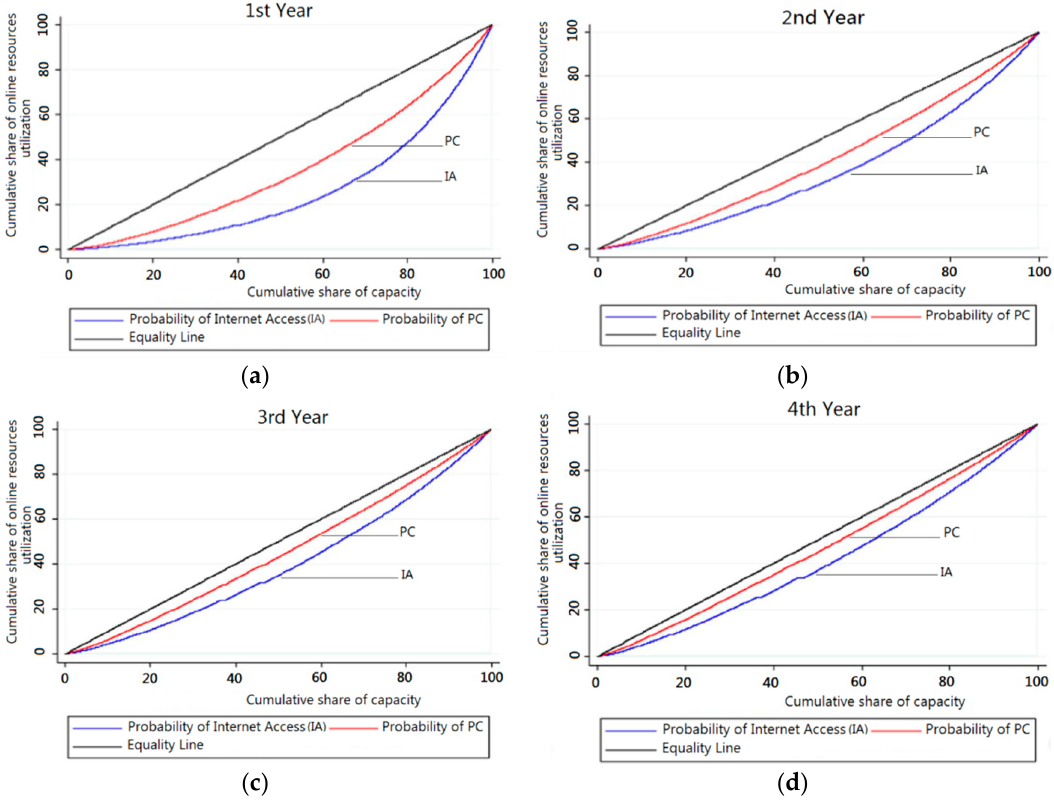
Figure 4. Evolution of the concentration curves of Internet access and computer property: ( a ) cumulative share of 1st-year students ranked by capacity; ( b ) cumulative share of 2nd-year students ranked by capacity; ( c ) cumulative share of 3rd-year students ranked by capacity; and ( d ) cumulative share of 4th-year students ranked by capacity.